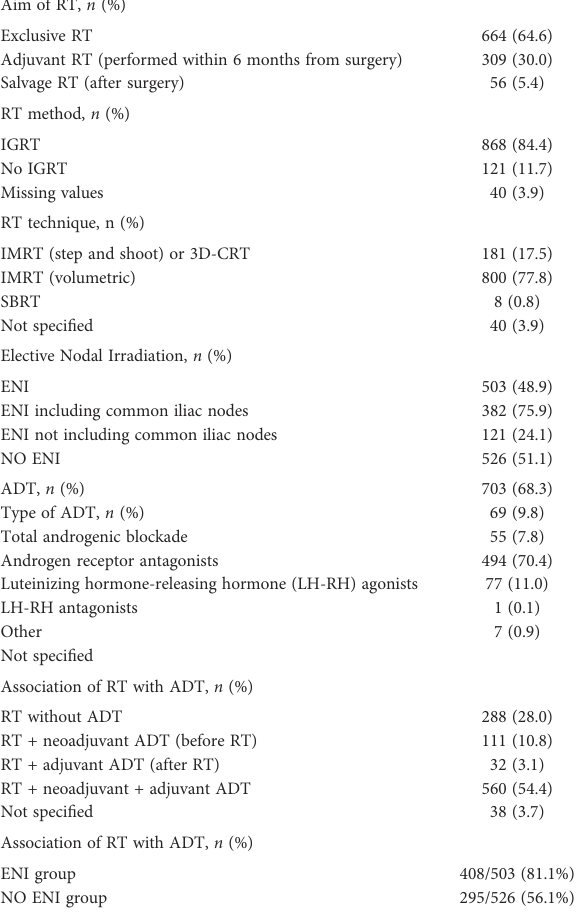
TABLE 2 Radiotherapy and hormone therapy